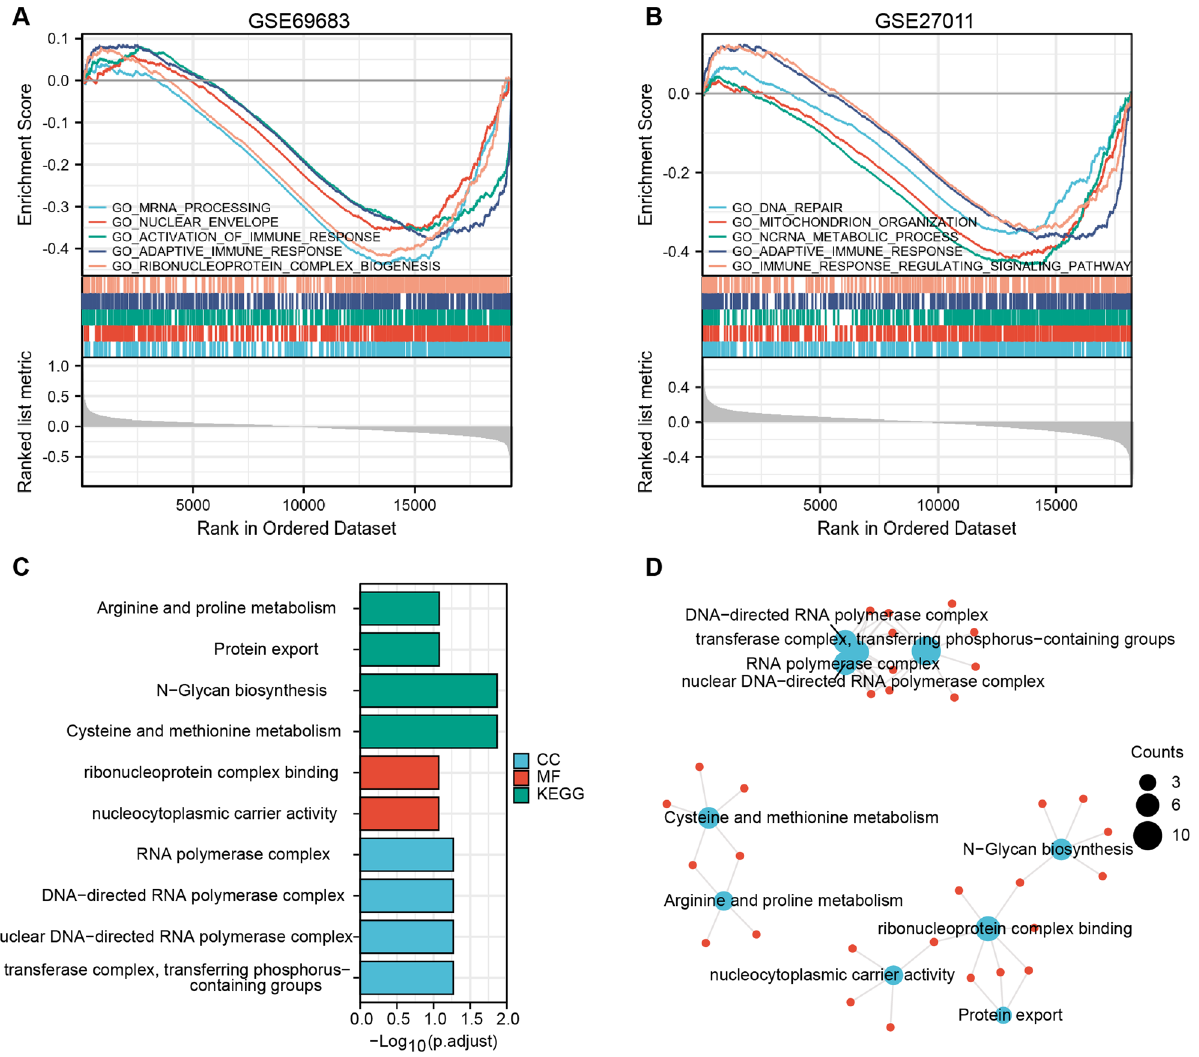
Figure 2. Enrichment analysis. GSEA analysis for GSE69683 ( A ) and GSE27011 ( B ). The results include upper, middle, and lower parts. The upper part: the peak in the right represents core molecules were mainly concentrated in the mild-moderate asthma group; the middle part: each vertical line represents a molecule in the gene set; the lower part: visualization of values given by the uploaded normalized data. GO and KEGG analysis for DEGs displayed in the form of histogram ( C ) and the network diagram ( D